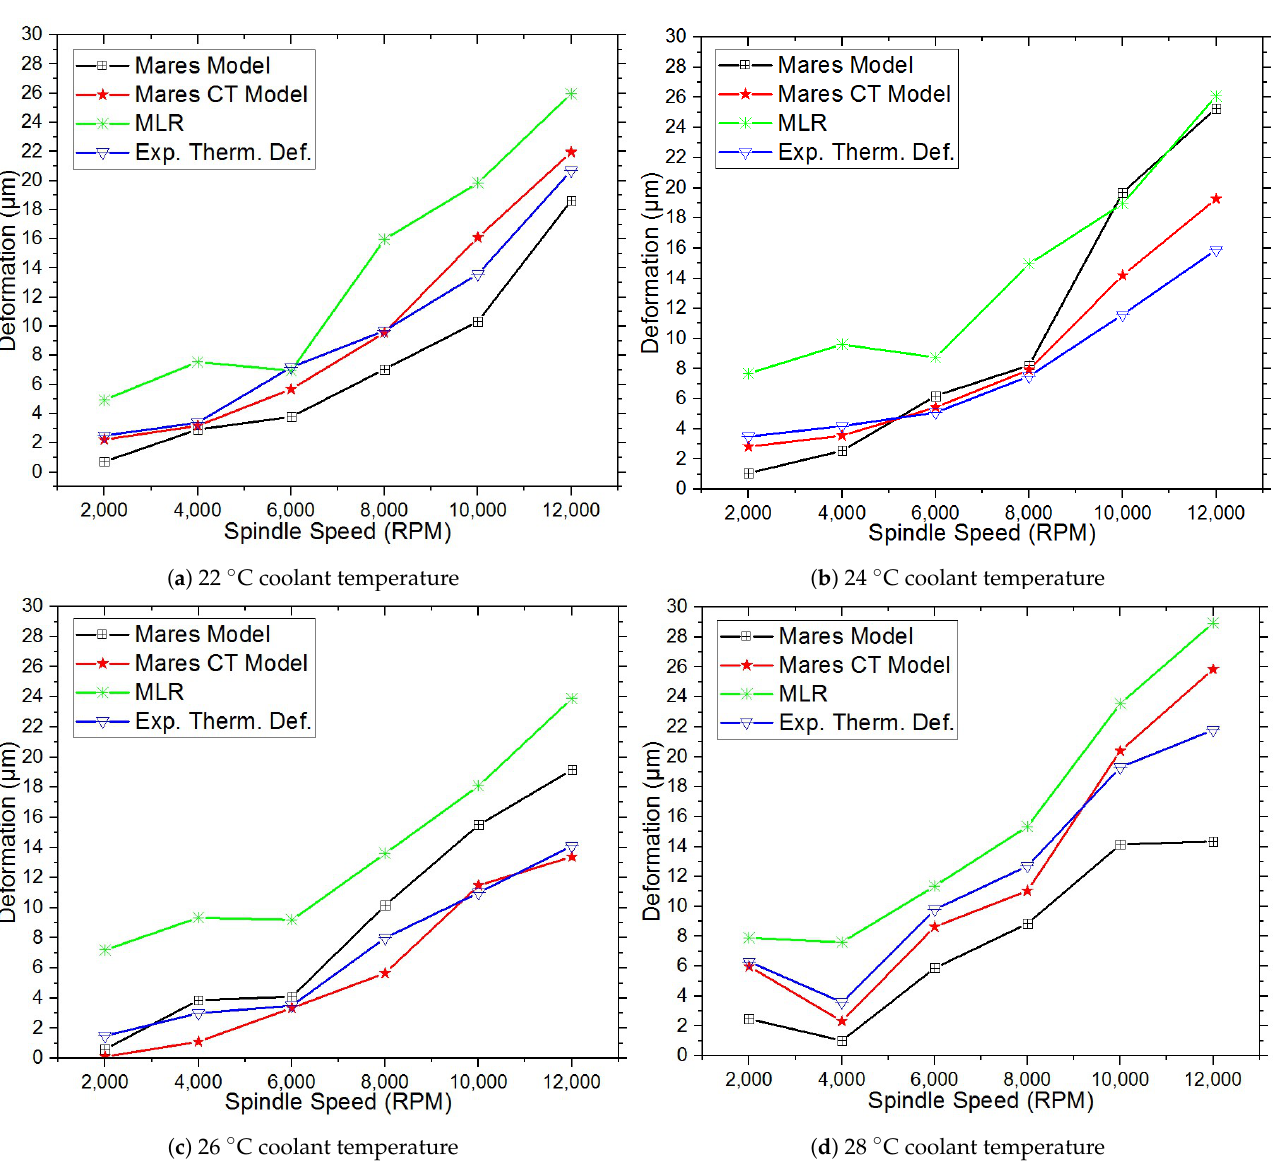
Figure 7. Thermal deformations of the CNC machine with a direct-drive spindle in steady-state operations at different coolant temperatures and spindle rotating speeds with a constant coolant flow rate (5 LPM) and 26 ◦ C ambient temperature; ( a ) 22 ◦ C coolant temperature; ( b ) 24 ◦ C coolant temperature; ( c ) 26 ◦ C coolant temperature; and ( d ) 28 ◦ C coolant